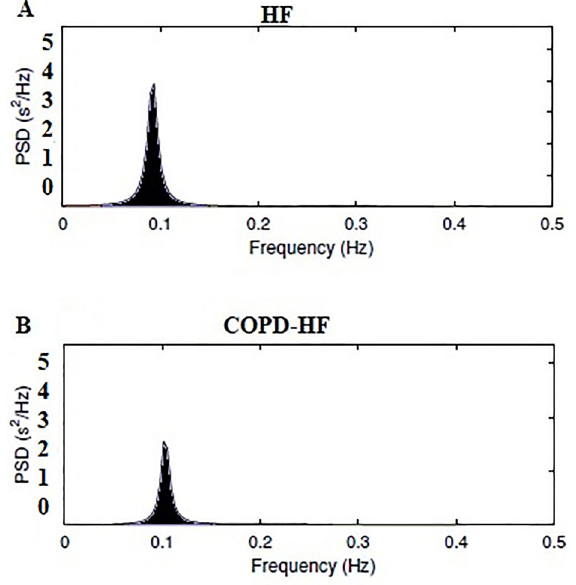
Figure 1. Decomposition of the spectrum into single spectral components in respiratory sinus arrhythmia maneuver (RSA-M). A , Heart failure (HF) patient (2 ’ 30 ’’ of RSA-M). B , Chronic obstructive pulmonary disease-heart failure (COPD-HF) patient (2 ’ 40 ’’ of RSA-M). PSD: total spectral